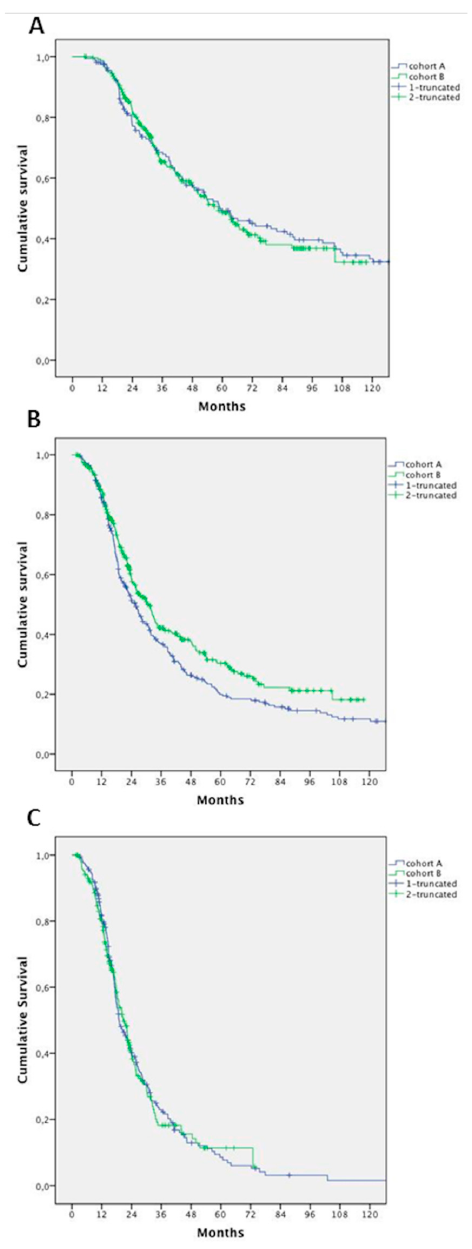
Figure 3. Survival analysis according to treatment in Cohort A and B: ( A ) patients undergoing systemic treatment and surgery; ( B ) patients undergoing systemic treatment and surgery, excluding patients who had hepatic resection alone; and ( C ) patients undergoing exclusively systemic treatment.